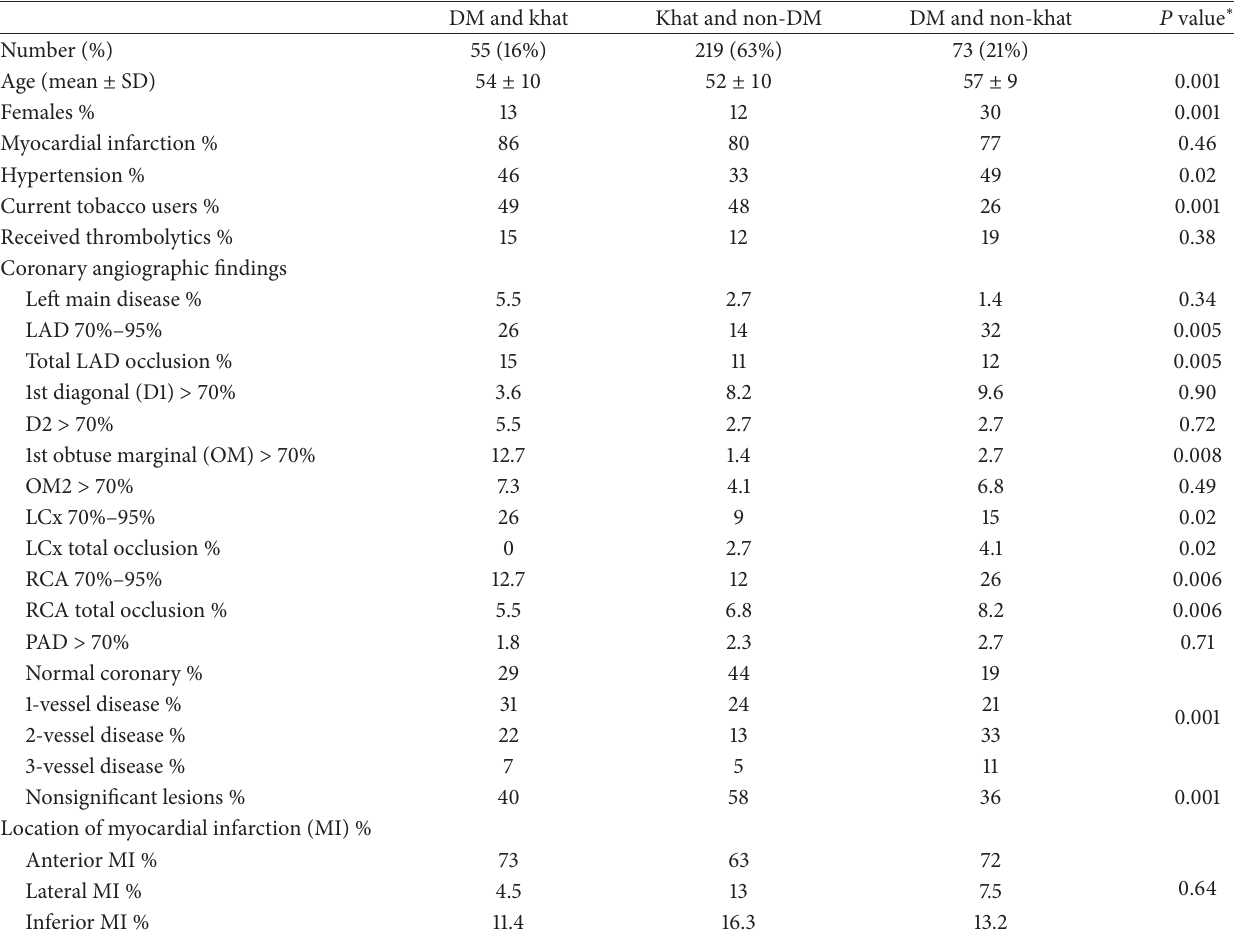
Table 1: Demographic, clinical presentation, and coronary morphology in patients with acute myocardial infarction.